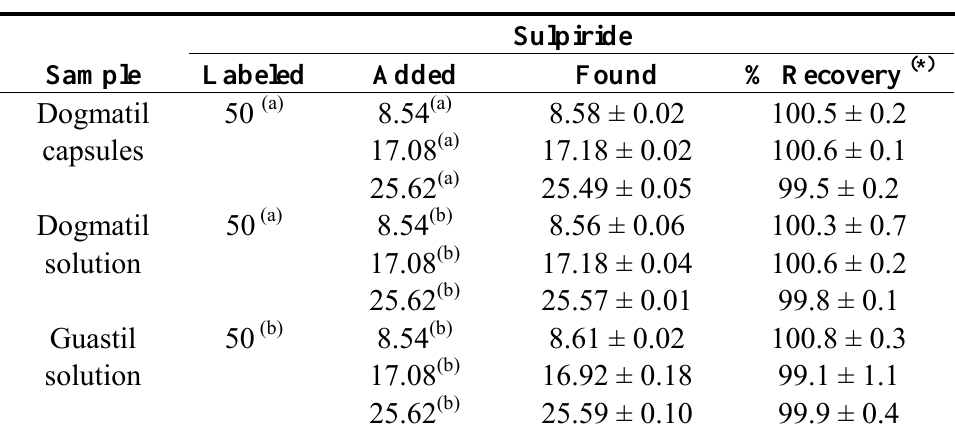
Table 5. Determination of sulpiride in